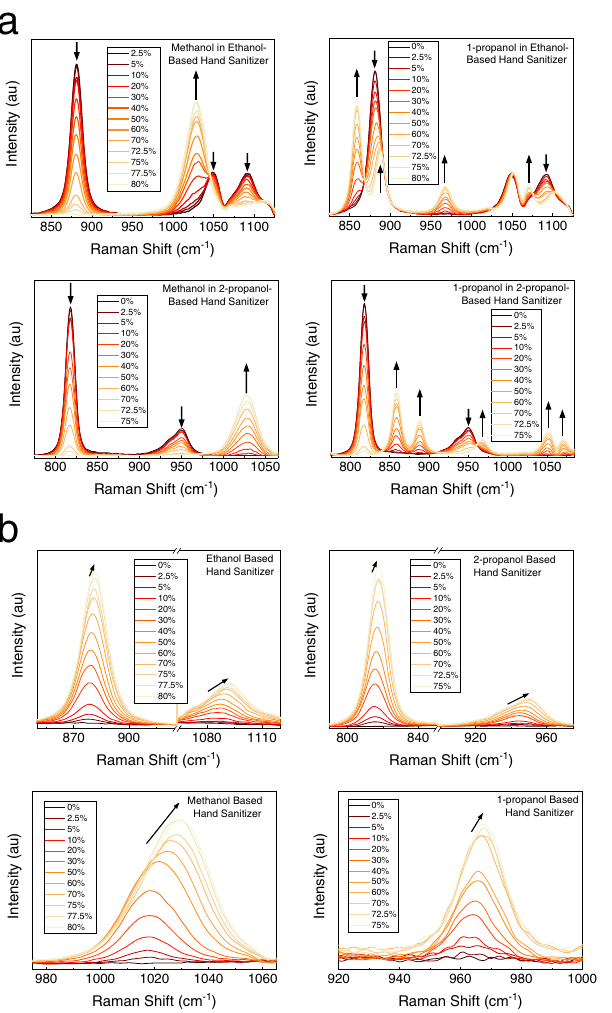
Fig. 2 Raman spectra of contaminated and subpotent hand-sanitizer formulations. Raman spectra of hand-sanitizer formulations with a ethanol, 2-propanol, methanol, and 1-propanol mixtures at a fi xed total alcohol concentration and b varying amounts of alcohol and water.